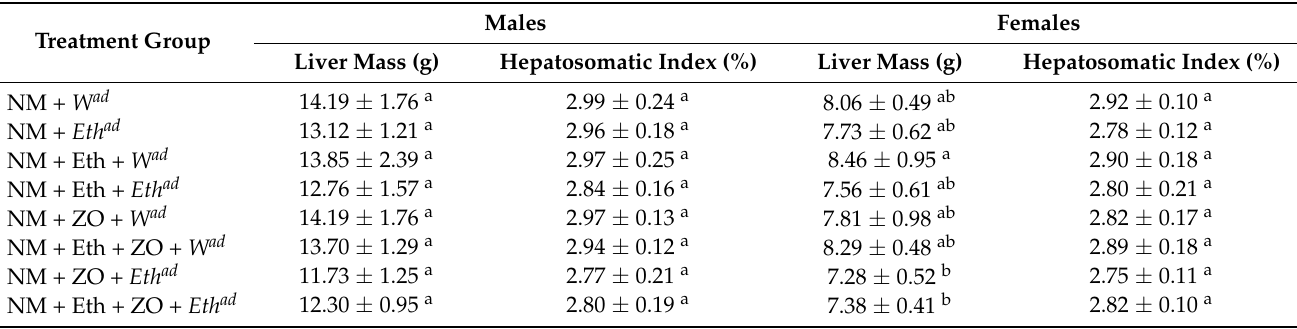
Table 1. Effect of neonatal orally administered zingerone on absolute liver mass and hepatosomatic indices in male and female rats drinking alcohol in